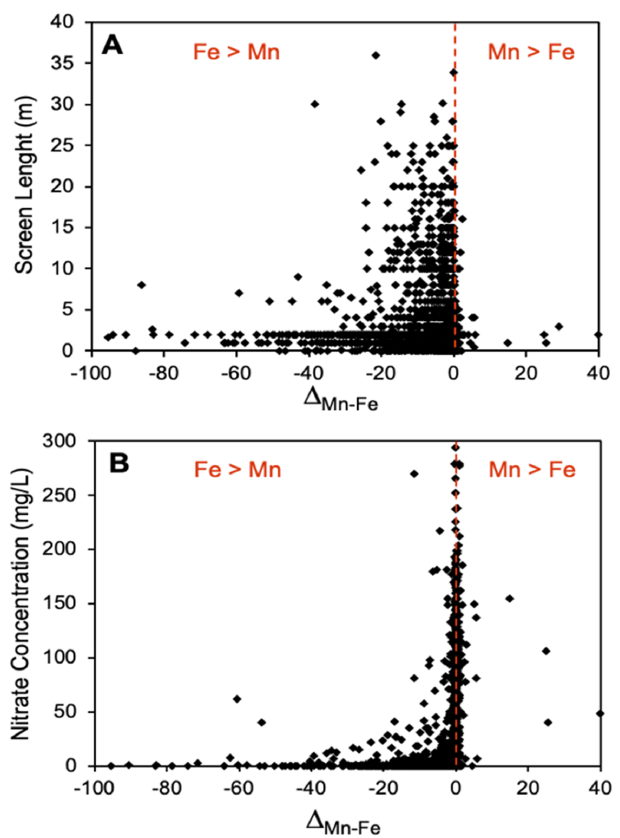
Figure 7. Relationship between monitoring well screen length ( A ), nitrate concentration ( B ) and ∆ Mn-Fe . Large variations are only seen in wells with shorter screens.